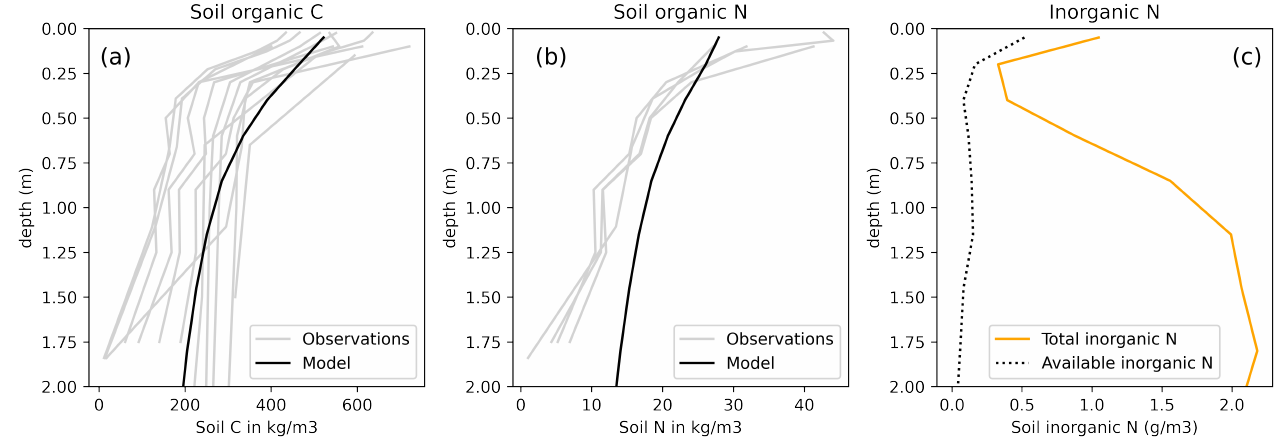
Figure 4. Profile of ( a ) organic C, ( b ) organic N and ( c ) inorganic (mineral) N within the permafrost— for the period 2000–2009 simulated using the CN spun configuration and the transient-ens. The obser- vations are derived from a range of available data sets described in more detail in the